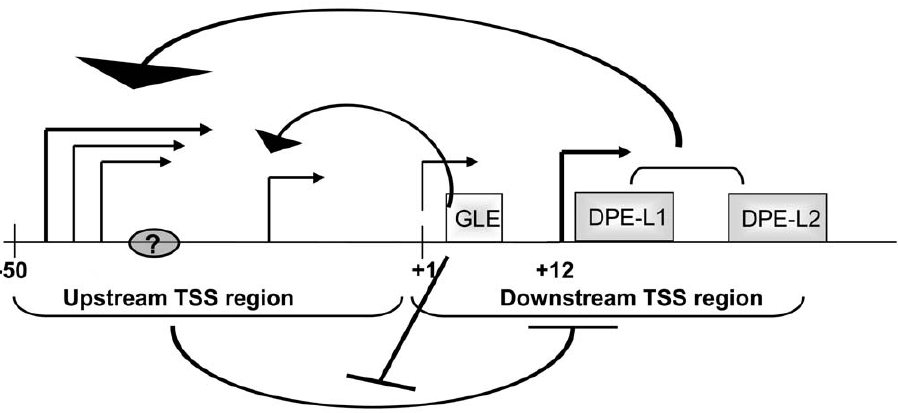
Figure 8. Model of MHC class I gene transcriptional regulation by novel downstream elements. In this model, GLE, DPE-L1, and DPE-L2 regulate the activity of transcription initiating at the upstream region of the promoter (upstream TSS region). GLE and DPE-Ls play different roles: while DPE-Ls enhance transcription from the upstream start sites (arched backward arrows), GLE inhibits the negative regulation of downstream start sites (downstream TSS region) by upstream promoter region (T-shaped symbols), leading to enhancement of transcription activity in a context- dependent manner. Since all three elements target upstream start sites, their activities are context- dependent: in activated transcription, where downstream start site usage is increased, they have less of an effect. Whether the observed negative regulation by the upstream promoter region reflects promoter competition by the upstream start sites (right-angle forward arrows) or the presence of an active negative regulatory element (indicated by shaded ellipse with ‘‘?’’) remains to be determined.